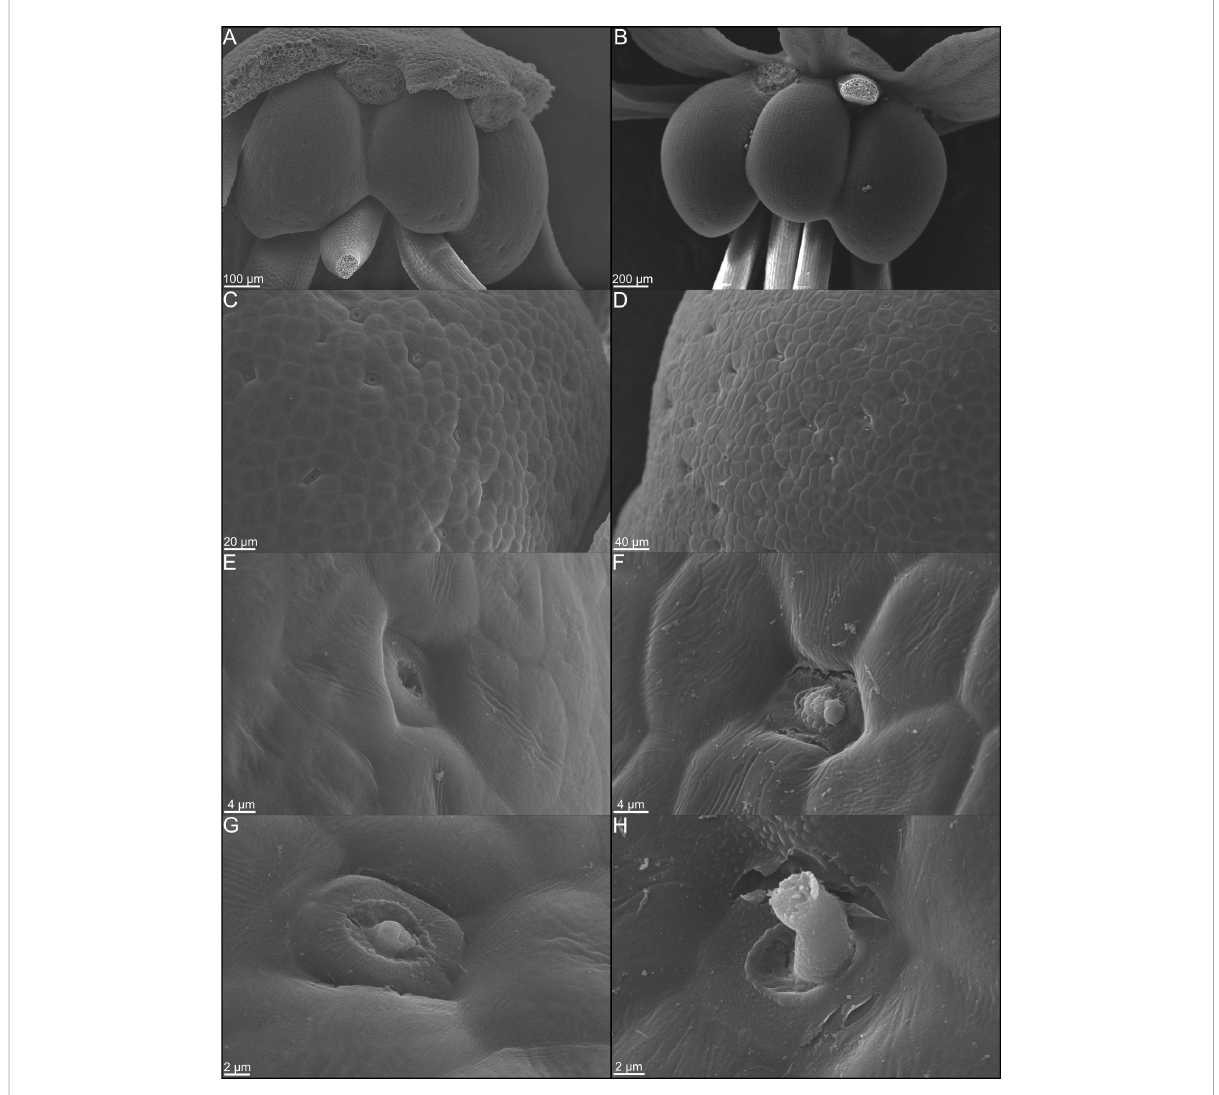
FIGURE 3 Scanning electron micrographs of whole nectaries from Cleome violacea at (A) pre-anthetic and (B) anthetic stages. (C) Distribution of nectarostomata on pre-anthetic nectary lobe and (D) anthetic nectary lobe. Examples of nectarostomata from (E – G) bud and (F – H) anthetic fl